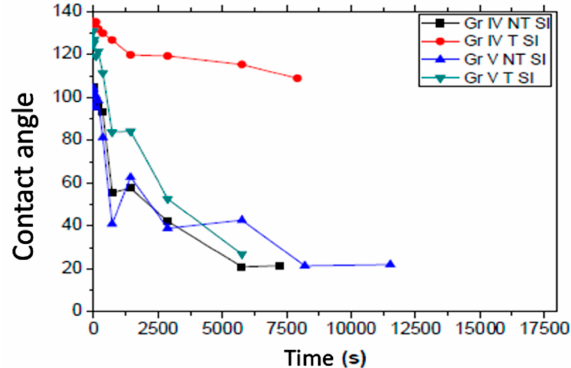
Figure 13. Progression of water contact angle regarding UV irradiation time on the grade IV and grade V samples with TiO 2 film (SI). Table 11. Initial and final water contact angles (on applying UV irradiation) of the grade IV and grade V samples with TiO 2 film. (GR IV: Titanium grade IV; GR V: Titanium grade V; T: SLA treated; NT: SLA non-treated; SI: Treated with TiO2